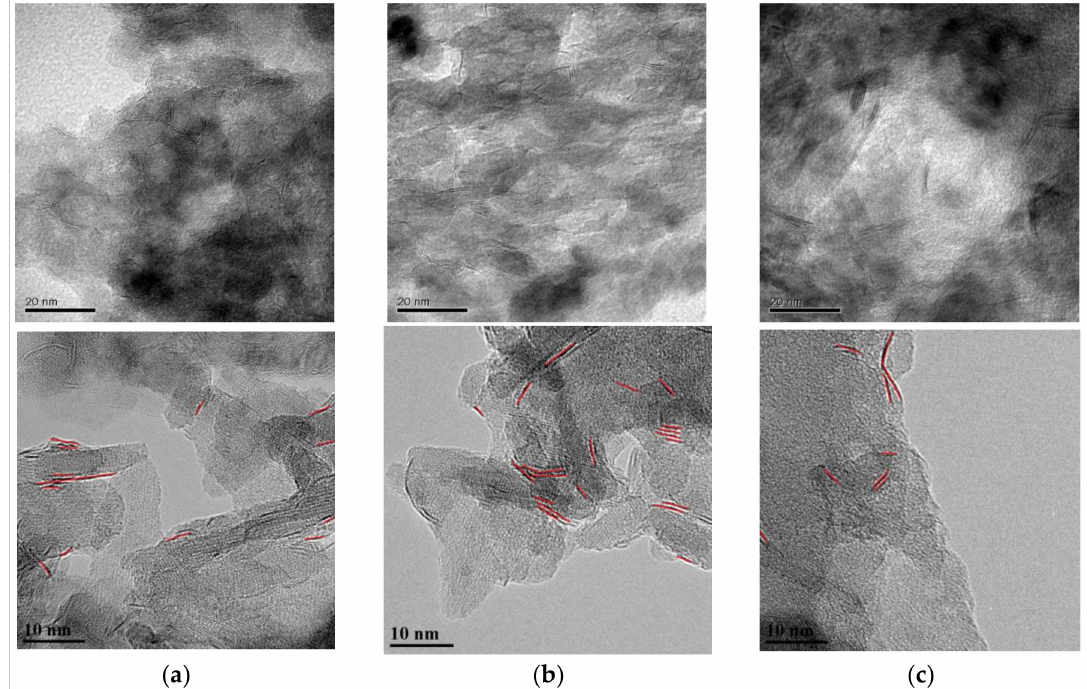
Figure 3. The representative TEM images of the sulfided catalysts. ( a ) CoMo/AZ; ( b ) NiMo/AZ; ( c ) NiW/AZ.